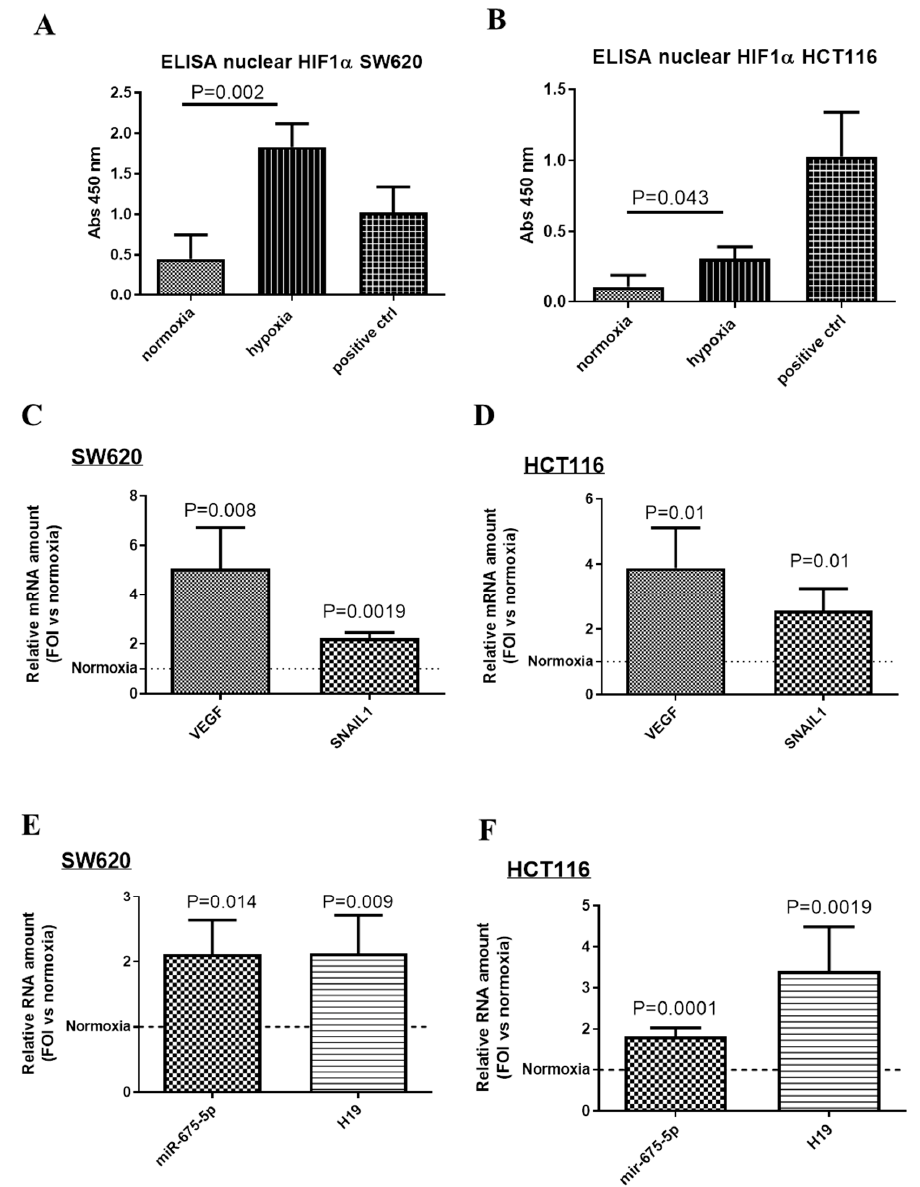
Figure 1. CRC cell lines up-regulated miR-675-5p and lncH19 after 18 h of hypoxic stimulation. ELISA assay for HIF-1 α performed with nuclear extracts of SW620 ( A ) and HCT116 ( B ) after 18 h of hypoxic stimulation, positive control was furnished by the kit and it is the nuclear extract of HeLa cells pretreated with LiCl. Data, expressed as absorbance (ABS) values at 450 nm, are the mean ± SD of three independent experiments. Real-time PCR for VEGF, SAIL1, miR-675-5p and lncH19 in SW620 ( C , E ) and HCT116 ( D , F ) stimulated for 18 h in the hypoxic chamber. MiR-675-5p data were normalized for RNU6 (RNA, U6 Small Nuclear 1) while VEGF, SNAIL1, and lncH19 levels were normalized for β -actin, ∆∆ Ct is expressed as fold of increase (FOI) with respect to normoxic conditions. Data are expressed as the mean ± SD of three independent experiments and p -values are indicated in the